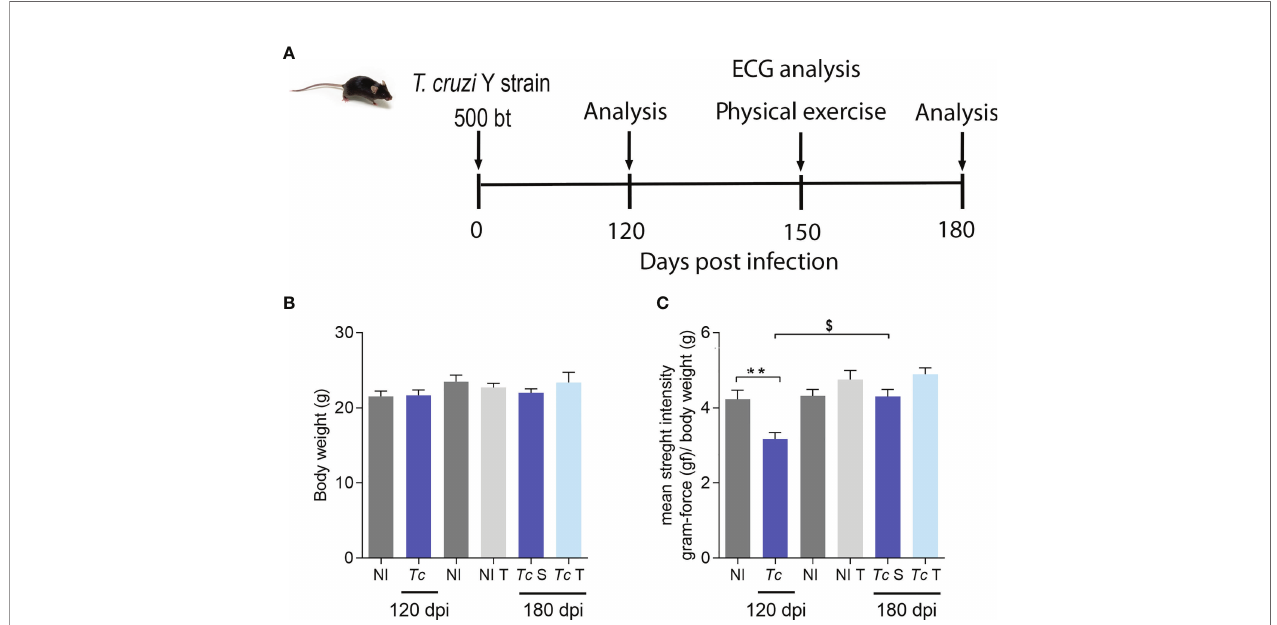
FIGURE 2 | T. cruzi infection does not change body weight but reduces muscular strength in C57BL/6 mice. Mice were infected with 500 trypomastigotes (Y strain). (A) Experimental design. (B) Body weight. (C) Muscular strength. The data are represented as means ± SEM. Data represent eight to nine mice per group. Signi fi cant differences between infected and uninfected groups. **p < 0.01. Signi fi cant differences between infected groups at 120 and 180 dpi. $ p > 0.05 ( Test t ; one-way ANOVA, Tukey posttest; Kruskal – Wallis Dunn ’ s posttest ; two-way ANOVA, Sidak ’ s posttest